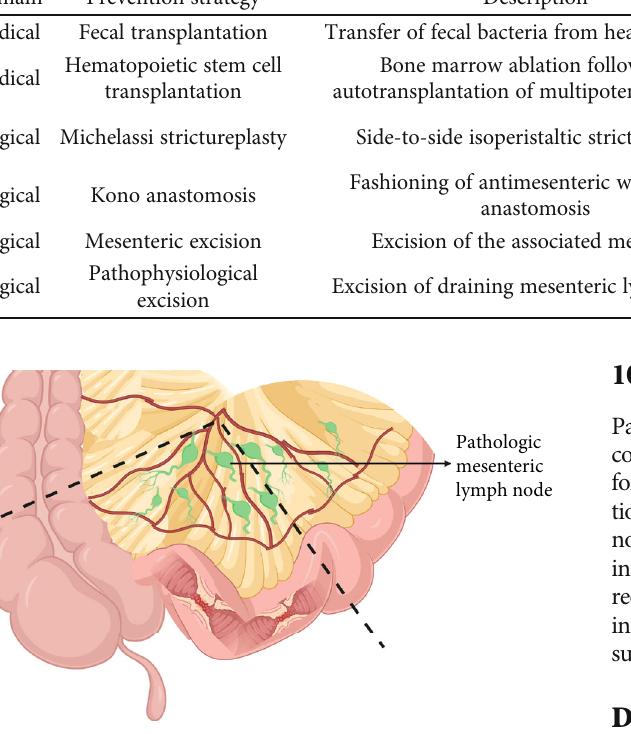
Figure 3: Pathophysiological excision for Crohn ’ s (PEC). Created with